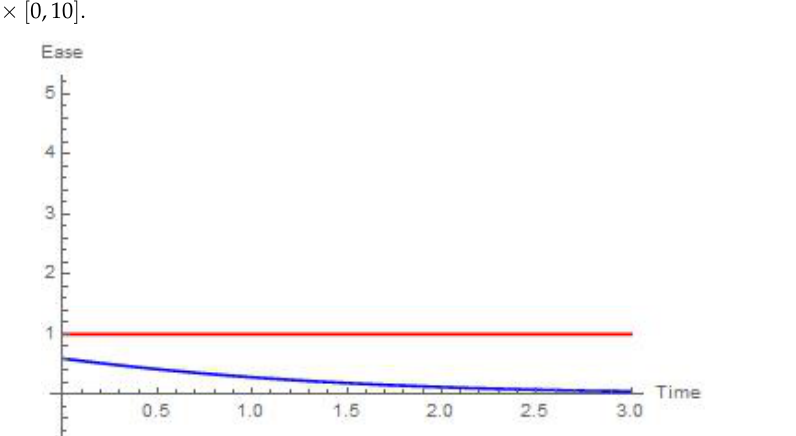
Figure 6. Ease of the extraction for the laws of Weibull (straight-red) and Chen (decreasing-blue) when δ 1 = 1 = δ 2 and λ 1 = 1 = λ 2